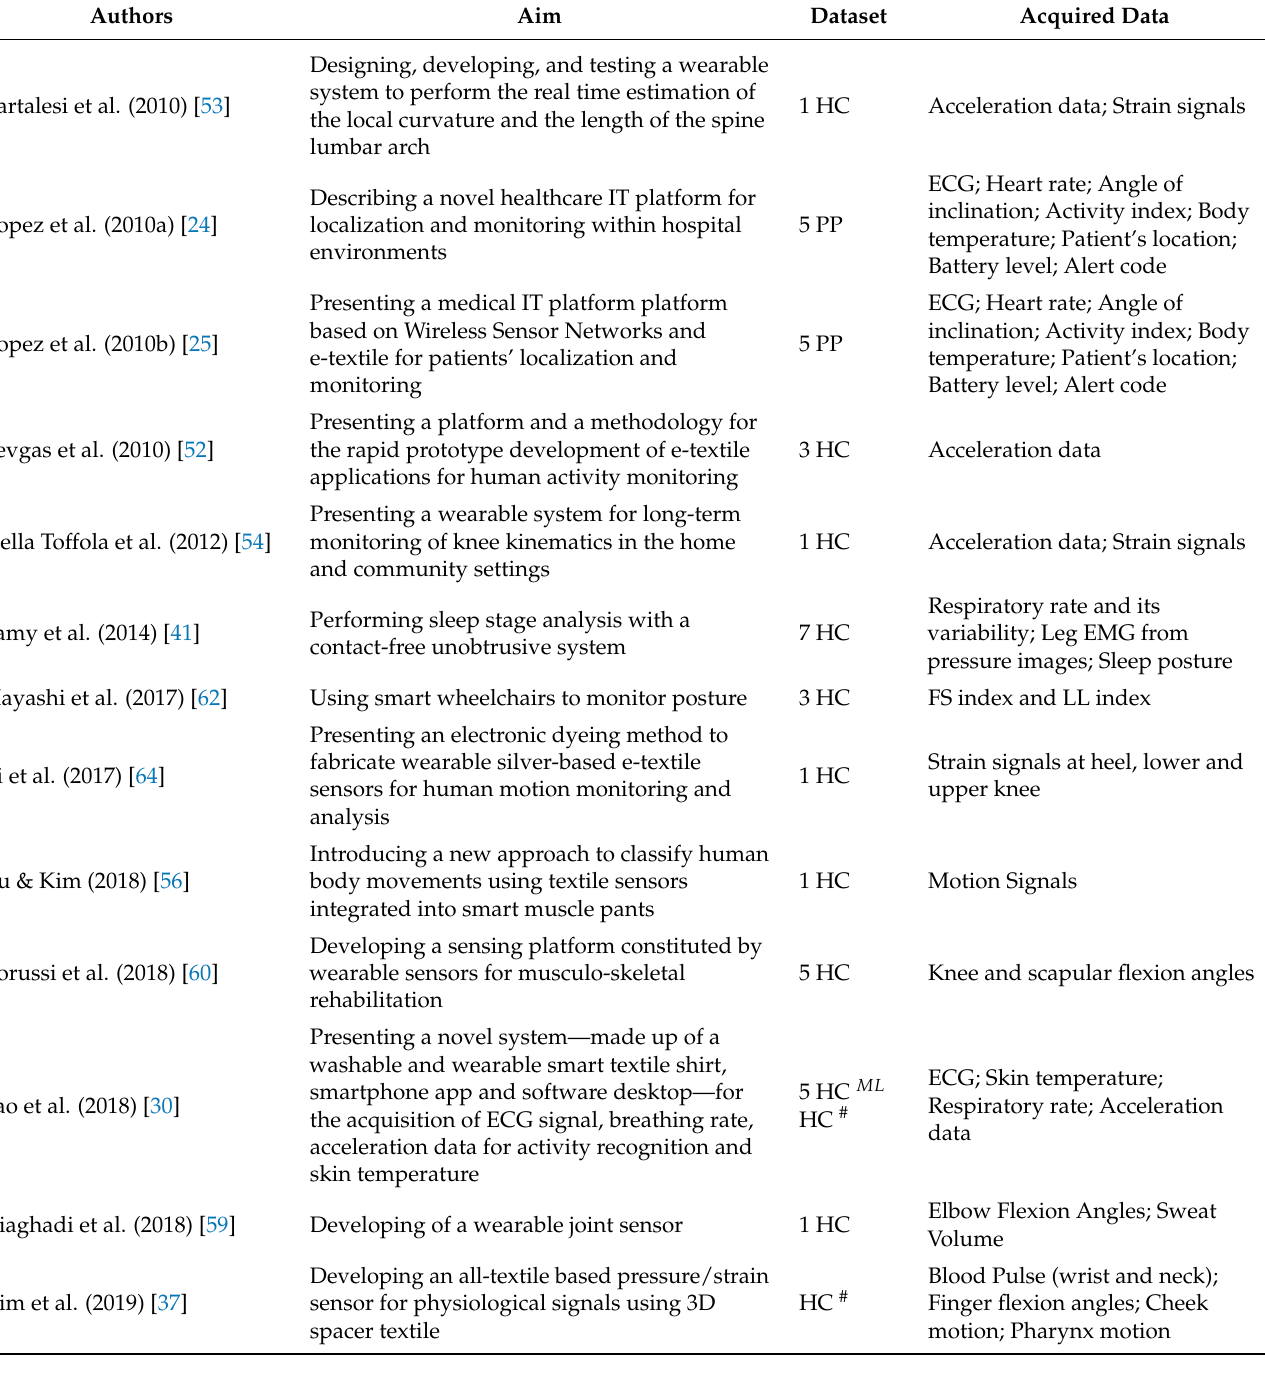
Table 4. Insights regarding orthopaedic literature: authors, aim, dataset, and acquired data.